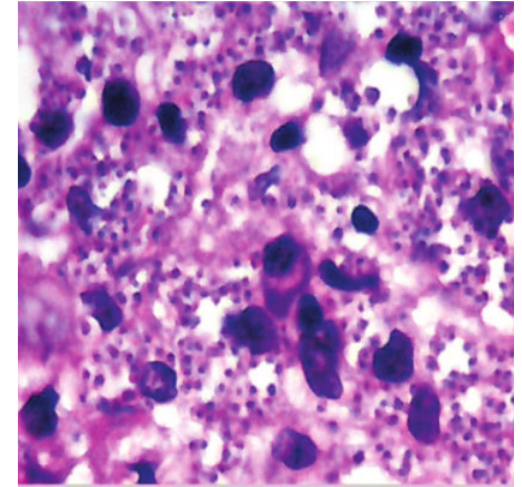
Figure 9: Skin biopsy from patient no. 2 shows many parasitized macrophages. Lymphocytes are